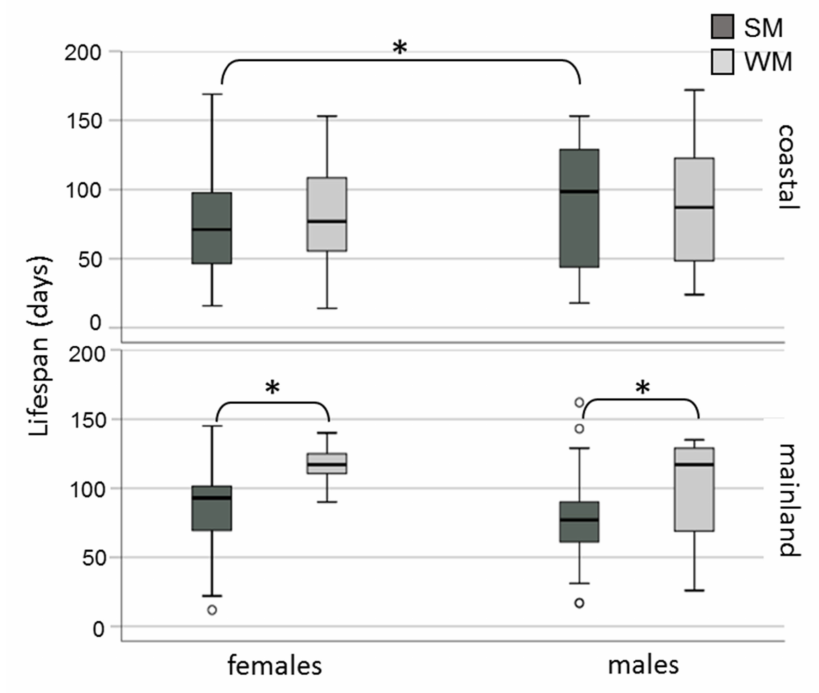
Figure 4. Lifespan (boxplots) of SM and WM of D. suzukii females and males exposed in field conditions in a coastal area of central Greece (Volos) and a mainland area of northern Greece (Naousa) from 1 November 2019 until the death of all individuals in May 2020. Values within the chart below the asterisk differ significantly ( p < 0.05). Circles depict outliers (numerically distant values from the rest of the